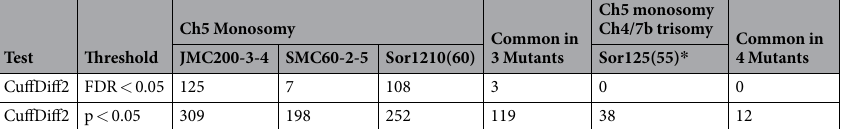
Table 4. Number of differentially expressed genes and genes in common on the monosomic Ch5 in different mutants, JMC200-3-4, SMC60-2-5, Sor1210(60), and Sor125(55). * Differential expression was assessed by Student’s t test. Note that a total of 521 genes are present on Ch5 in the RNA-Seq data for JMC200-3-4, SMC60- 2-5 and Sor1210(60) and 499 genes are present on Ch5 in the expression array data for